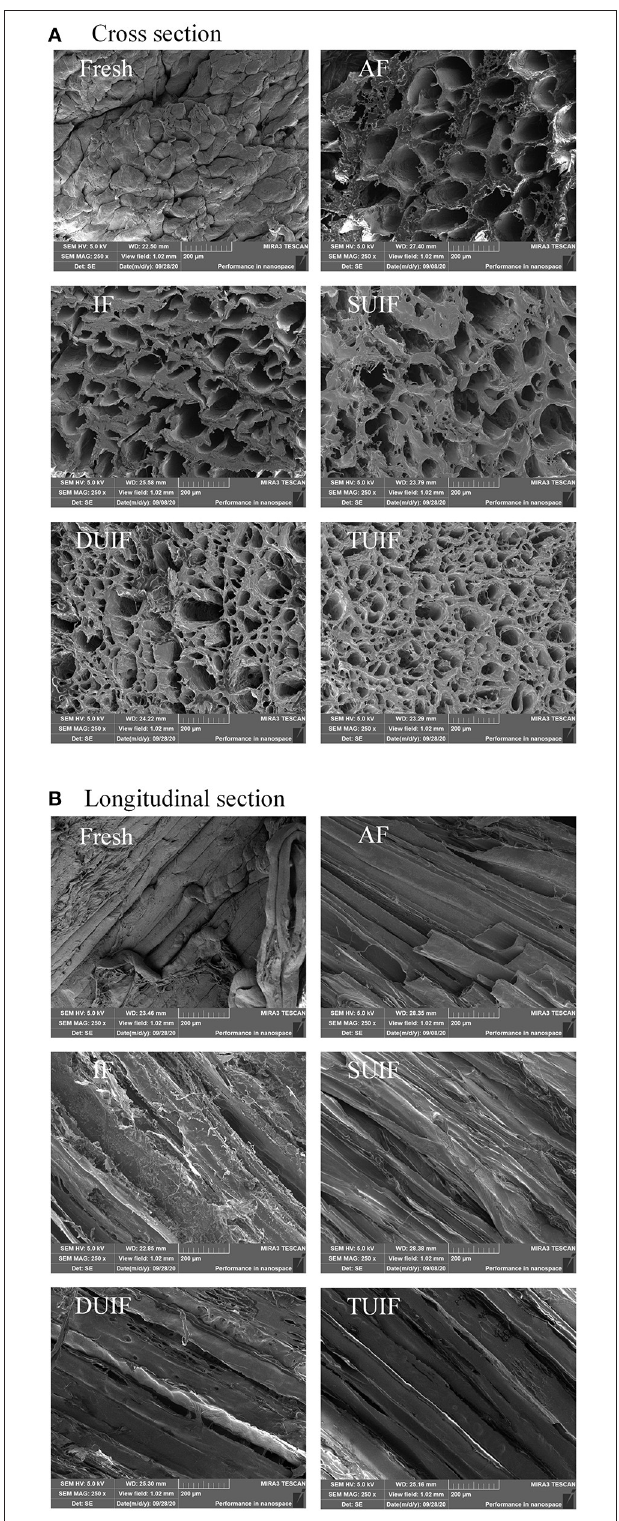
FIGURE 4 | Changes in SEM cross section (A) and longitudinal section (B) of large yellow croaker muscles microstructure after different freezing treatments (magnification: